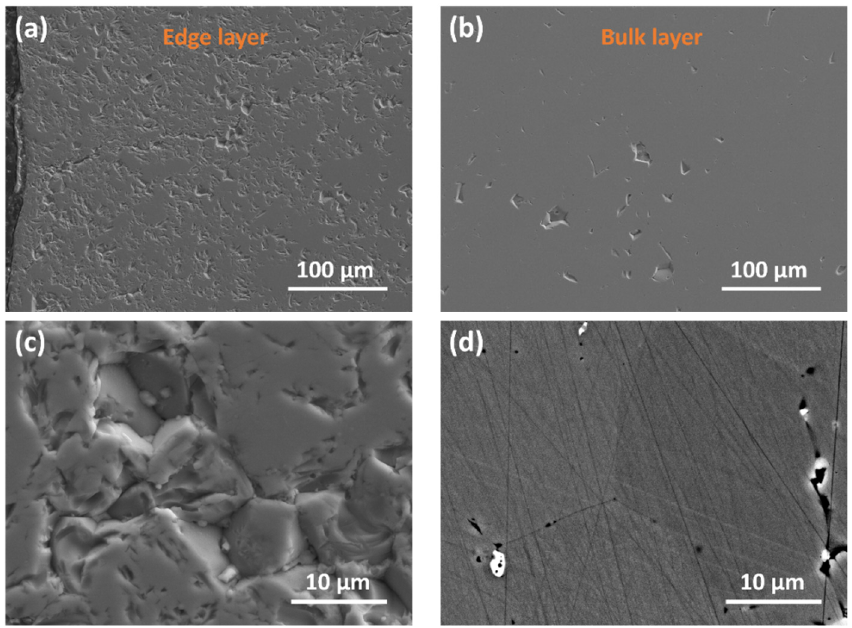
Figure 6. SEM images obtained for 0 GAlN ceramics: ( a , c )—edge layer ( b , d )—bulk layer.